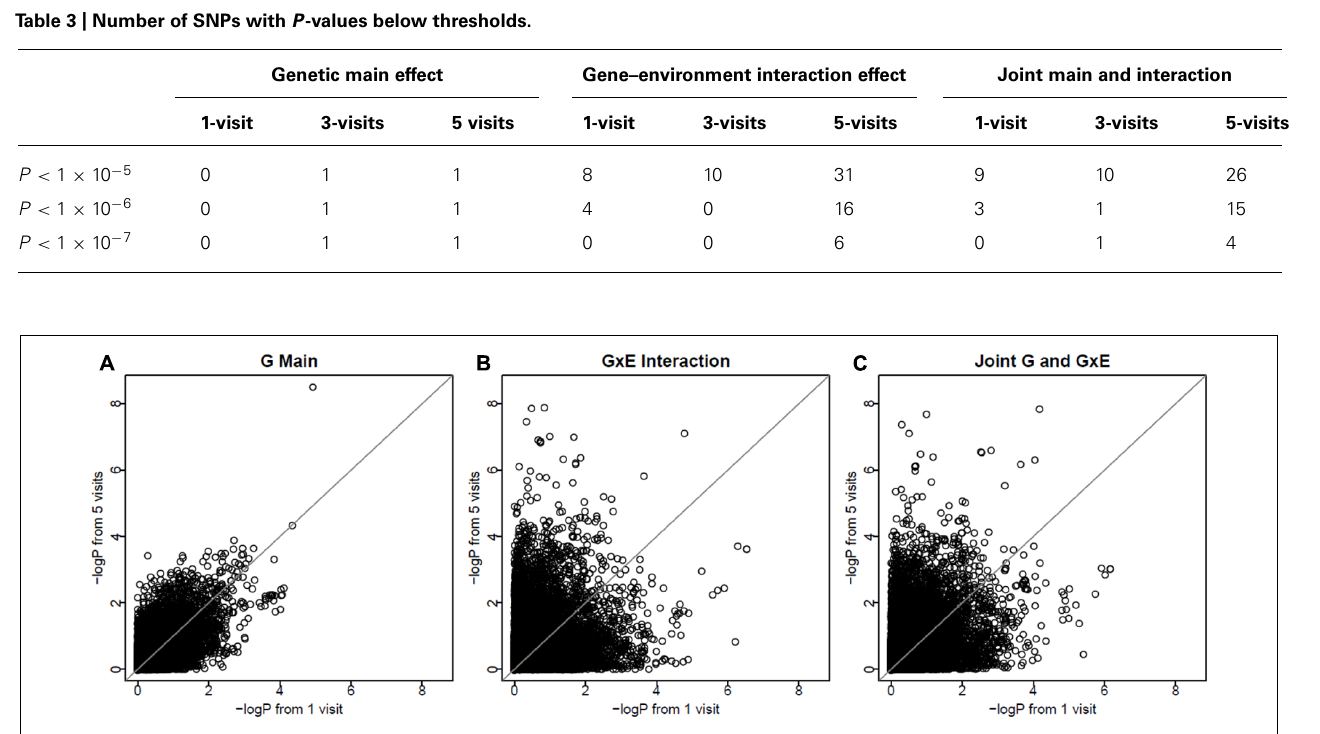
FIGURE 2 | More visits are better for identifying interactions. The x -axis shows − log( P ) values using the 1-visit data set, and the y -axis shows − log( P ) values using the 5-visit data set. More SNPs (53, 54, and 55% of SNPs in A–C , respectively) are above the diagonal